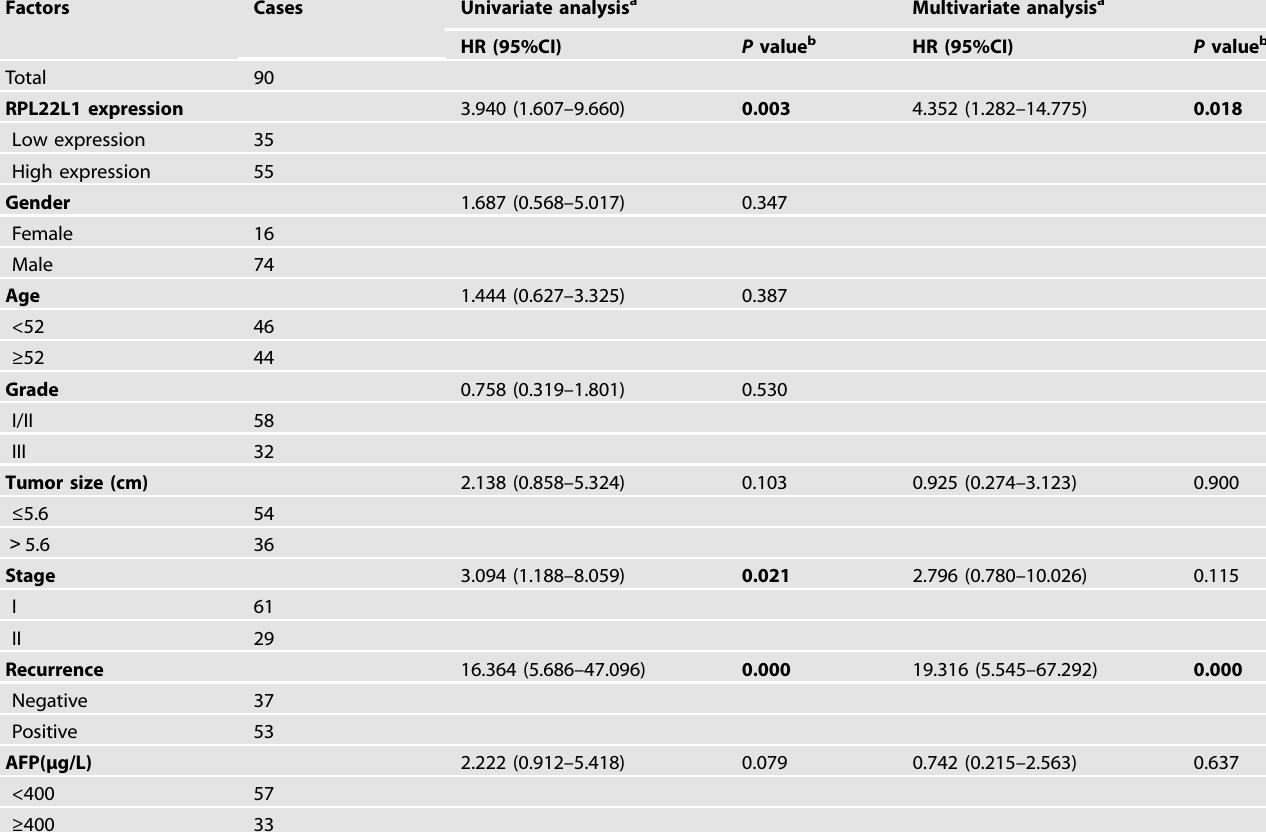
Table 2. Univariate and multivariate Cox regression analysis of different prognosis factors in patients with HCC from